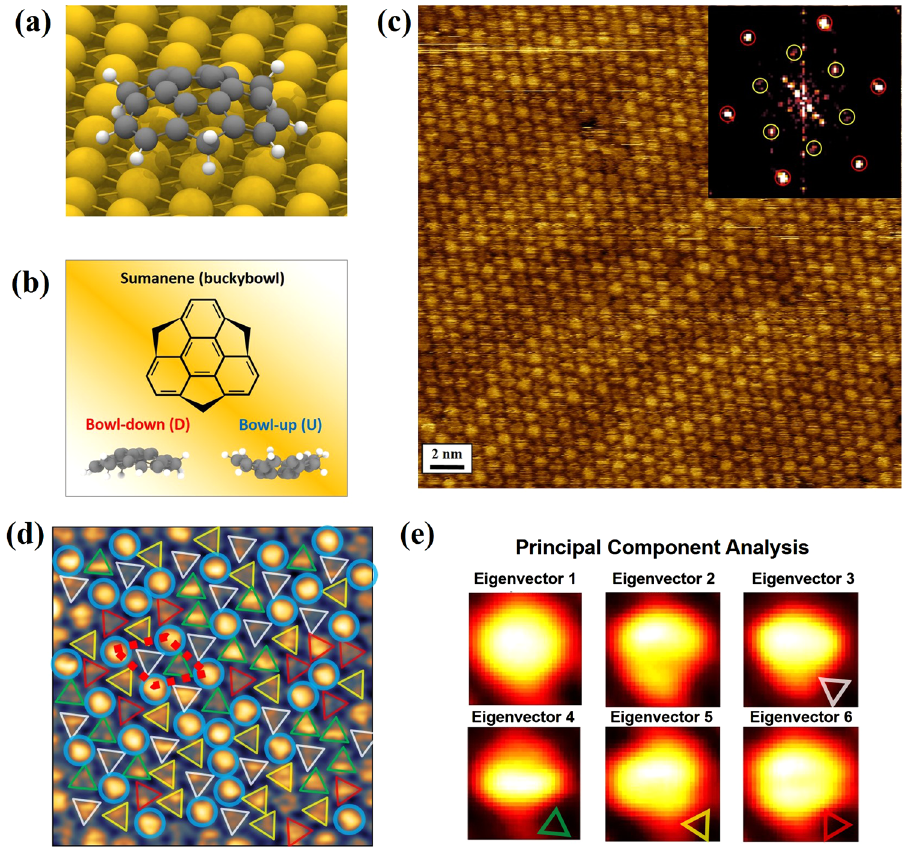
Fig. 1 Description of the system and physical priors. Schematics of a sumanene molecule on a gold substrate and b bowl-up ( U ) and bowl- down ( D ) conformational states. c Experimental STM image (raw data) of sumanene ad-layer structure on gold (111) surface. The image resolution is 910 px × 910 px. Inset shows a global Fast Fourier Transform of the STM image. The inner hexagon marked with yellow circles is due to formation of 2U1D structure in certain parts of the image. d Visual inspection of different conformational states ( U and D ) and rotational states from selected area of the STM image. The D states are marked by blue circles . The U states are marked by triangular whose orientation re fl ects a presence of different rotational states. e Principal component analysis on the dataset containing all the 938 molecules extracted from c . The fi rst eigenvector is the mean value whereas the rest fi ve eigenvectors correspond to the largest variances in the dataset (see also Supplementary Note 4) and can be linked to presence of different rotational classes (schematically indicated in the bottom right corner) observed e.g. in